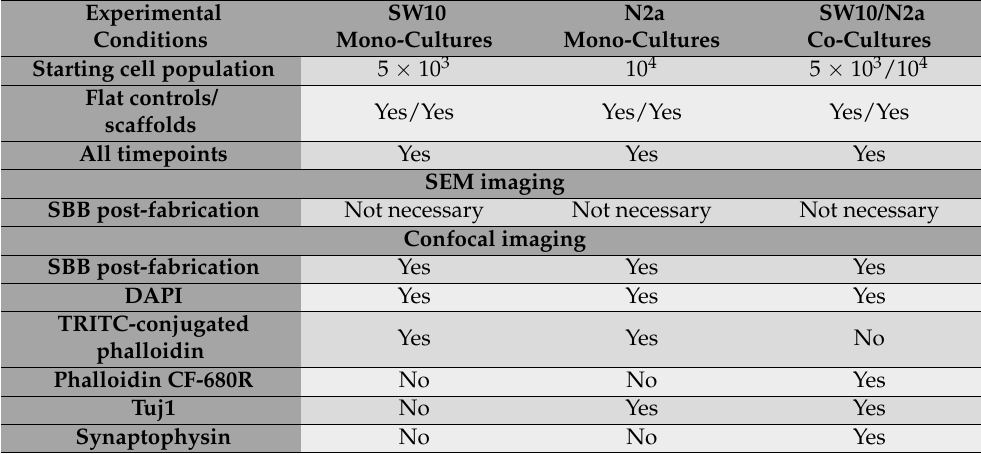
Table 1. Summary of the experimental conditions and parameters used in this work. Experiments were conducted at least in triplicate for each experimental condition.